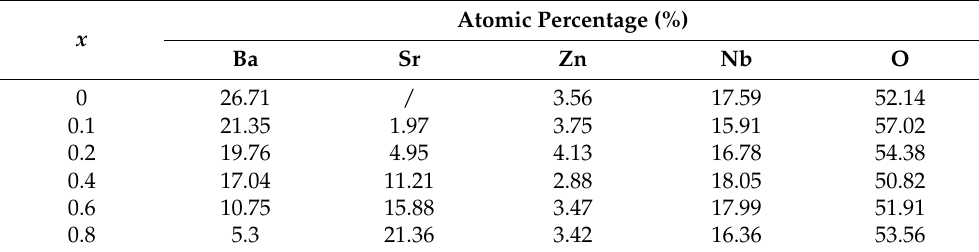
Table 2. EDS analysis of the BSZN samples with different Sr 2+ concentrations.